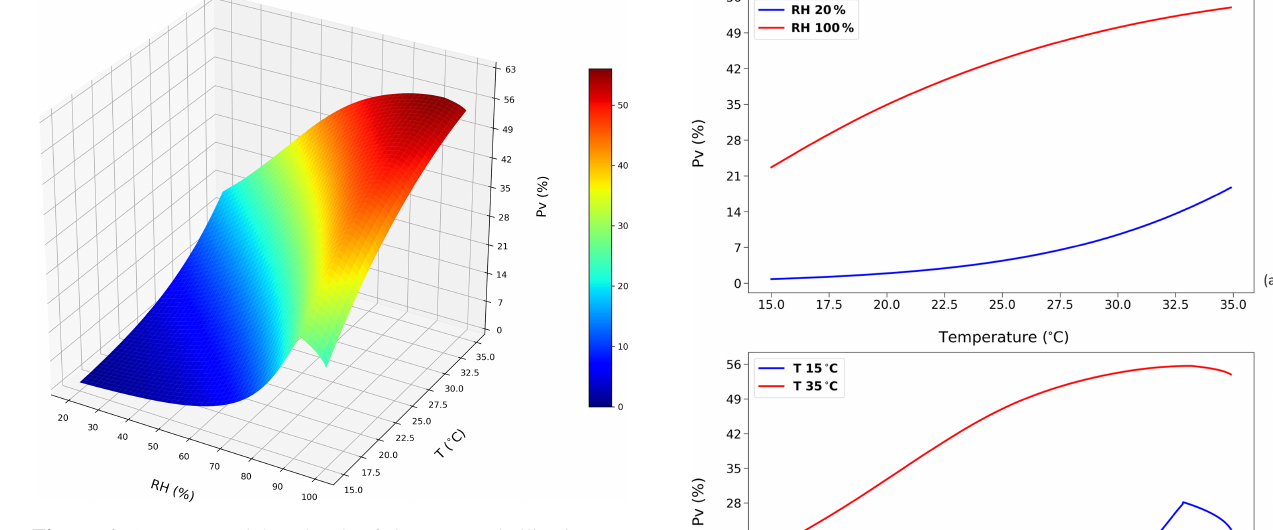
Figure 6. A conceptual 3D sketch of the NH 3 volatilization rate ( P V ) that is driven by temperature ( T ) and relative humidity (RH). The surface plot is derived from a set of idealized steady-state sim- ulations with zero precipitation to simulate dependences for emis- sions from chicken housing (see Sect. 2.2.1; shown using the new parameterizations for T and RH).